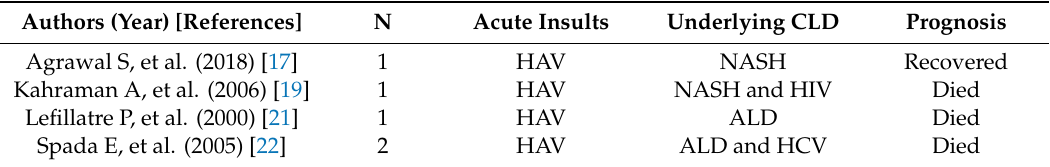
Table 1. Acute-on-chronic liver failure with hepatitis A virus (HAV) infection in patients